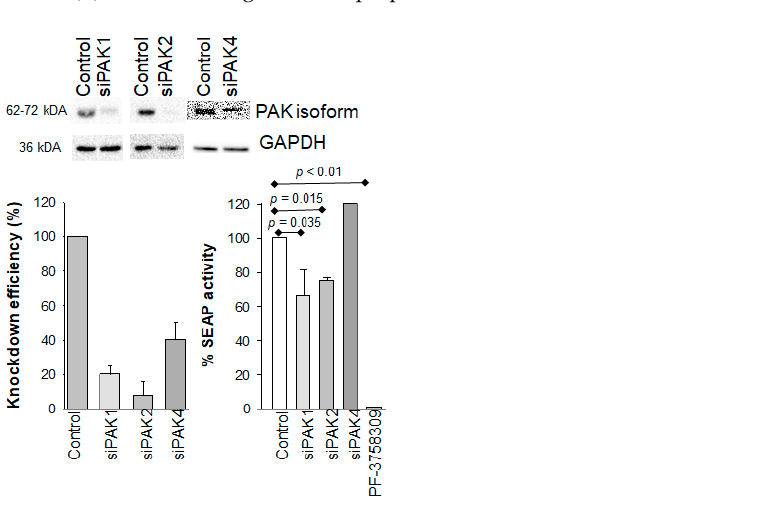
Figure 3. Effect of PAK1, PAK2, and PAK4 knockdown of HIV-1 latency reversal in 24ST1NLESG cells. (a) Representative Western blot analysis of PAK knockdown; (b) quantification of PAK knockdown by Western blot using ImageJ; (c) effect of PAK knockdown on HIV-1 latency reversal mediated by TNF- α in 24ST1NLESG cells. Data are shown as the mean ± standard deviation from at least three independent biological replicates. Statistical significance evaluated using Mann–Whitney U